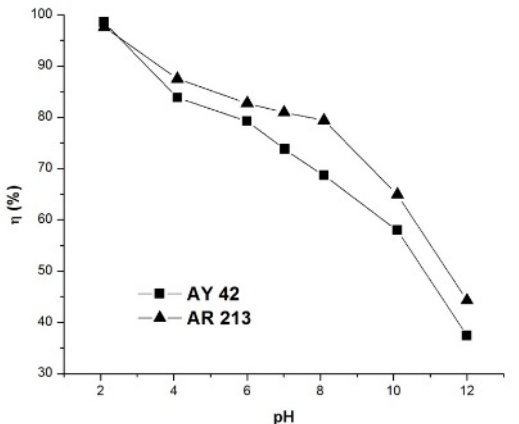
Figure 8. Effect of pH on dye removal efficiency using PM4; initial dye concentration 50 mg/L, 1 g/L PM4, contact time 120 min, 25 °C.